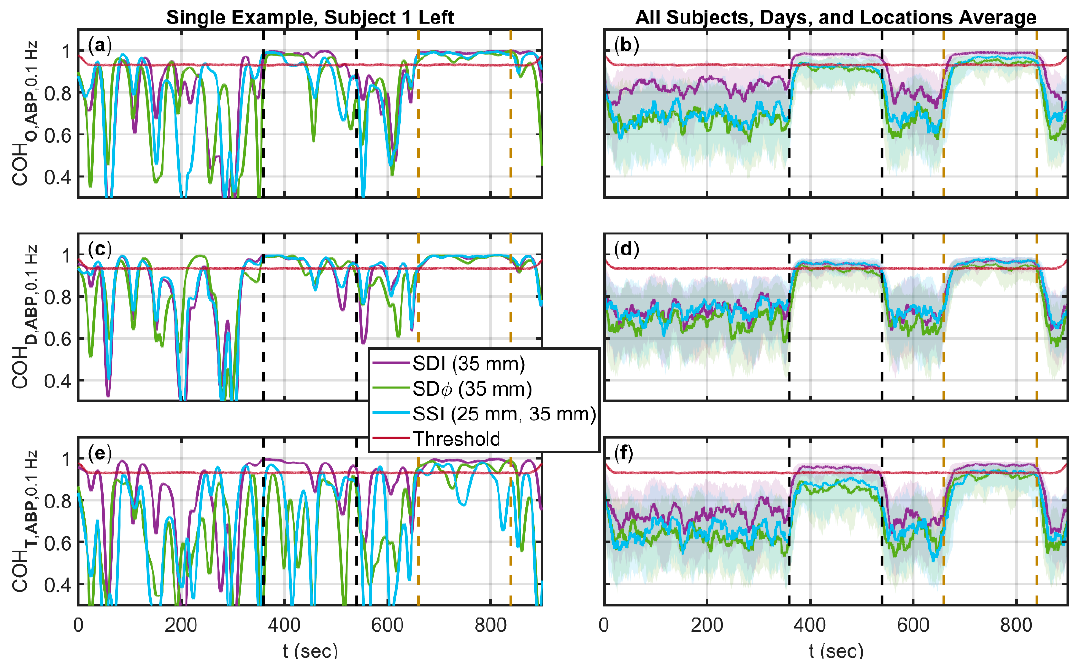
Figure 3. Time (t) traces of wavelet coherence (COH) at 0.1 Hz for three phasor pairs oxyhemoglobin ( O ) and arterial blood pressure ( ABP ), deoxyhemoglobin ( D ) and ABP , and total hemoglobin ( T ) and ABP . Shown for three analysis methods single-distance intensity (SDI, purple), single-distance phase (SD ϕ , green), and single-slope intensity (SSI, cyan). Threshold of significant wavelet coherence is shown (maroon). Time periods of induced cuff oscillations (dashed black) and induced paced breathing (dashed mustard) oscillations shown. ( a , b ) COH between O and ABP at 0.1 Hz. ( c , d ) COH between D and ABP at 0.1 Hz. ( e , f ) COH between T and ABP at 0.1 Hz. ( a,c,e ) Example subject, day, and location. ( b,d,f ) Average across all subjects, days, and locations, with error regions shown as interquartile range (IQR).